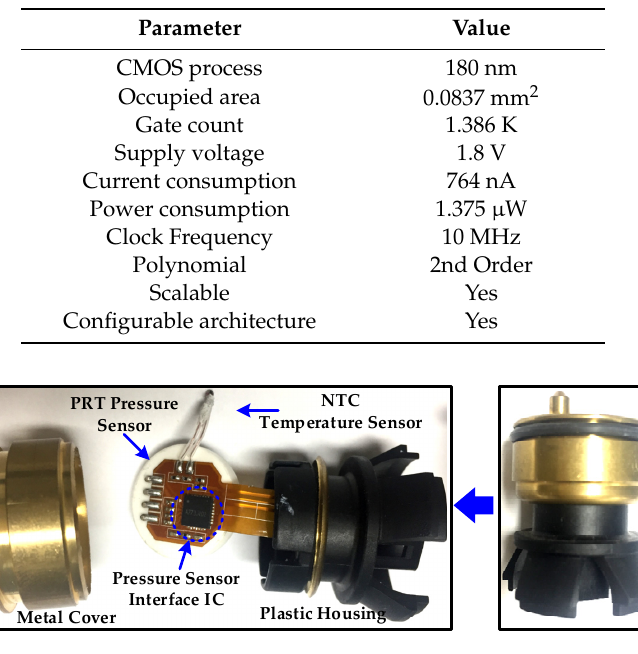
Figure 10. PRT pressure sensor module with PRT and negative temperature coefficient (NTC) sensors and proposed temperature compensation.